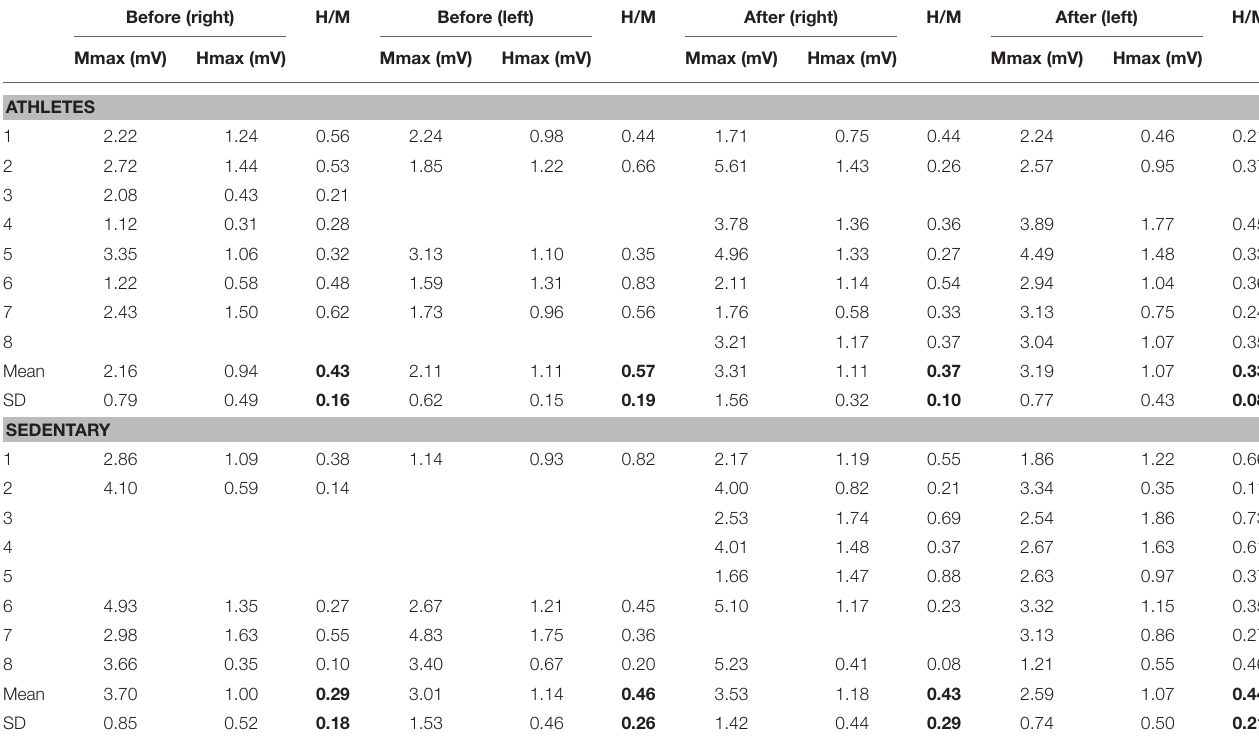
TABLE 5 | Summary of raw data per subject for Hmax, Mmax, and their ratio. Before (right) H/M Before (left) H/M After